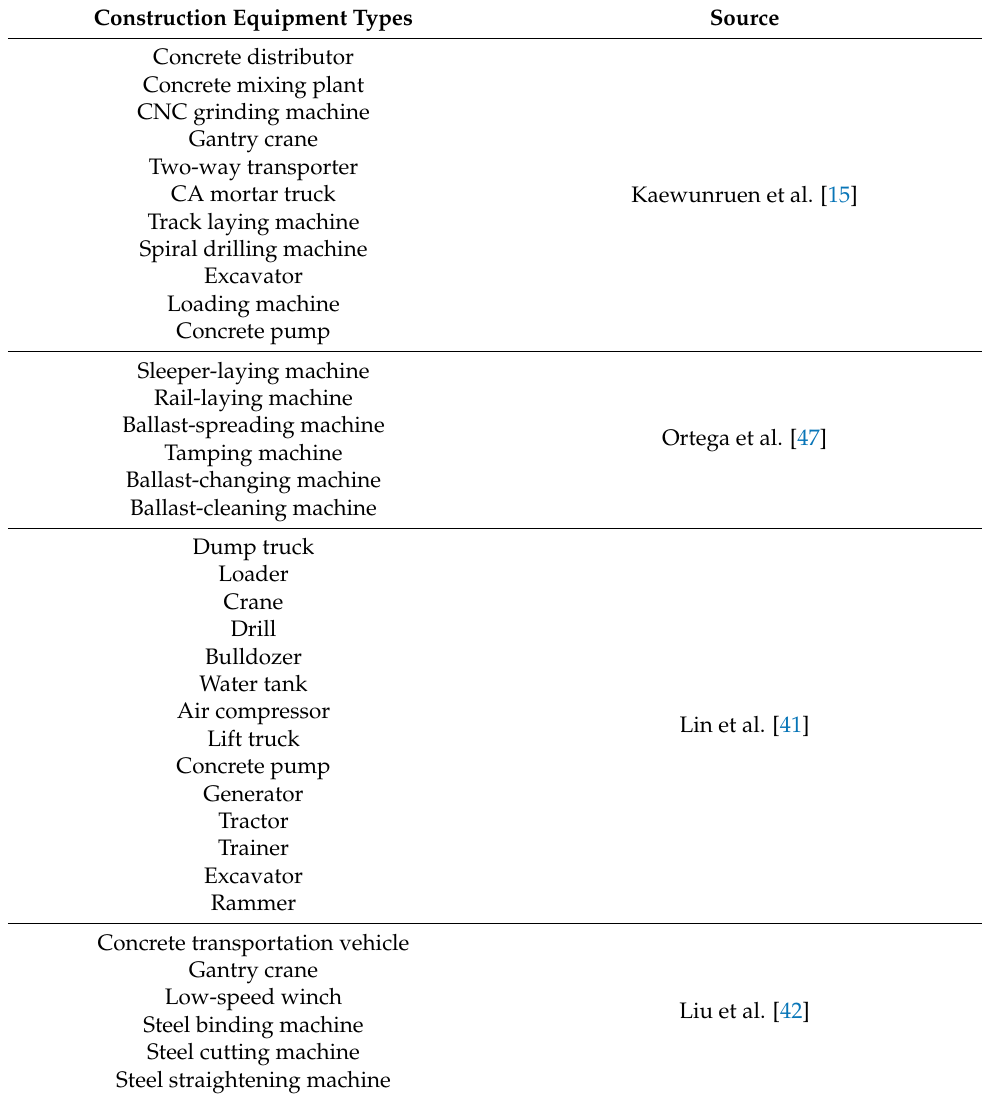
Table 3. Construction equipment CEFs based on